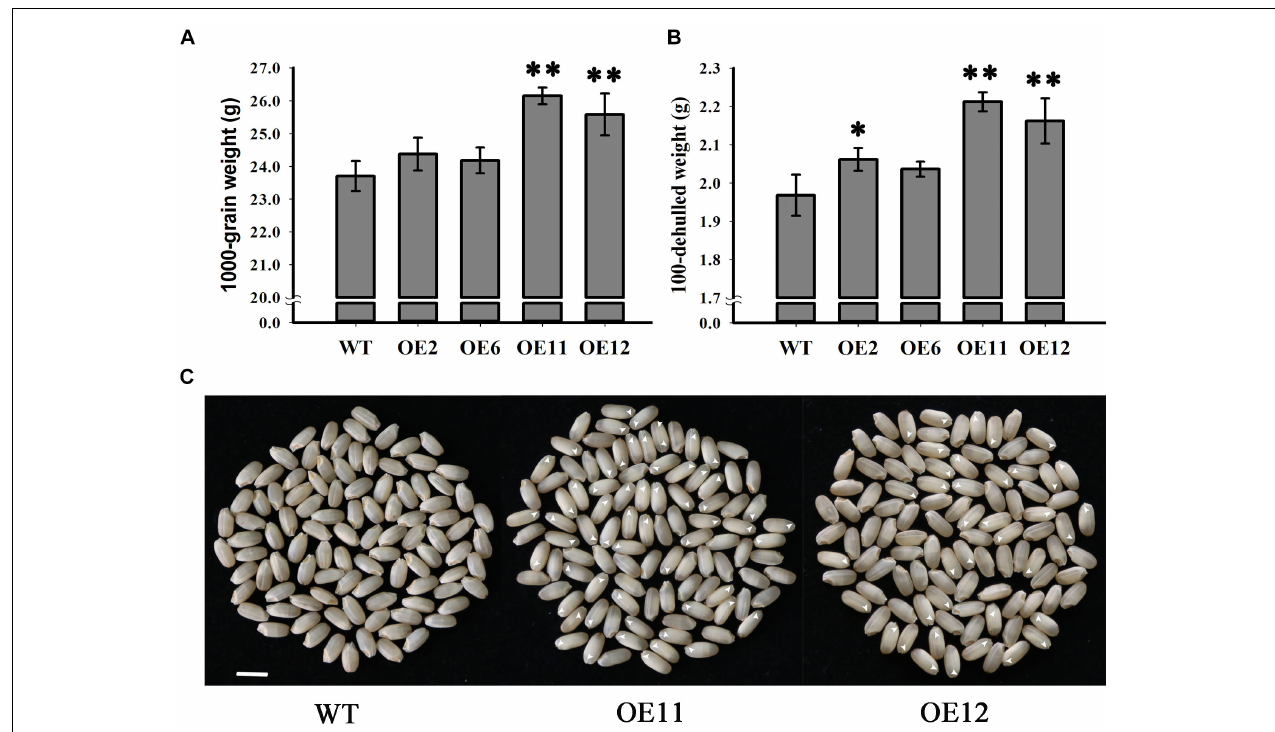
FIGURE 6 | Analysis of grain weight in WT and OsGrxC2.2 -Overexpression lines. (A) 1000-grain and (B) 100-seed weight of WT and OsGrxC2.2 overexpression line (OE2, OE6, OE11, and OE12) seeds. (C) Phenotypical comparison of seeds from WT and the OsGrxC2.2 overexpression plants. Bar = 0.5 cm. Arrows: embryoless seeds. Statistical significance is indicated by ∗∗ p < 0.01 and ∗ p <